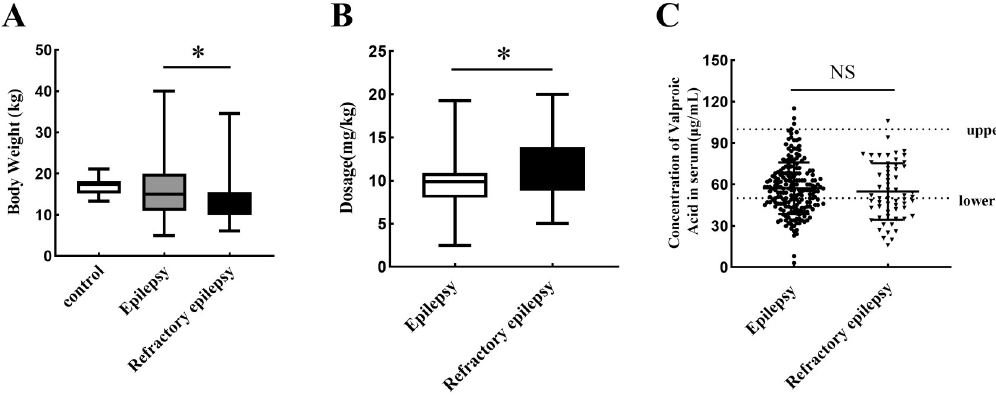
Fig 1. General information and serum VPA concentration in the epilepsy and refractory epilepsy patients. A . The difference of weight between the three groups. B . The difference of sodium valproate dosage between the two groups. C . Changes of serum VPA concentration, upper shows 100 μ g/ml, lower shows 50 μ g/ml. NS shows no difference, * indicated p <